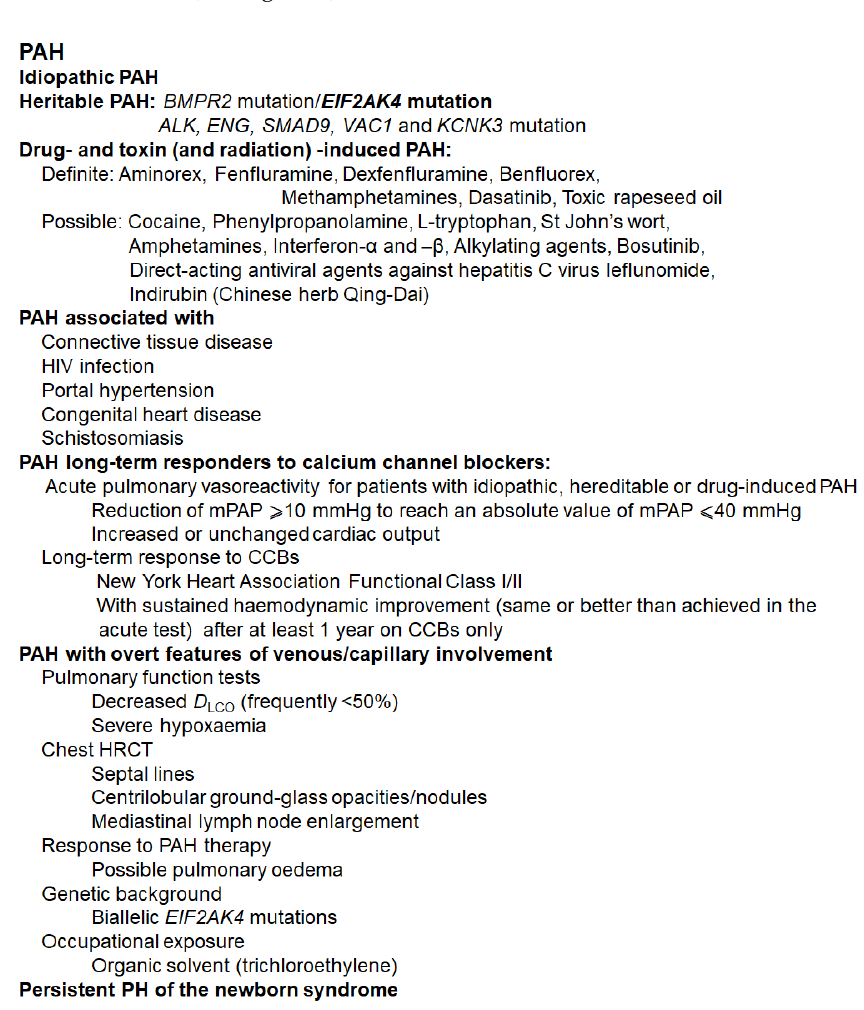
Figure 1. Current classification of PAH. Abbreviations: CCB, calcium channel blocker; mPAP, mean pulmonary arterial pressure; PVOD, pulmonary veno-occlusive disease; PCH, pulmonary capillary hemangiomatosis; DLCO, diffusing capacity of the lung for carbon monoxide; HRCT, high-resolution computed tomography; BMPR, bone morphogenic protein receptor type II.; ALK1, activin receptor-like kinase 1; ENG, endoglin; CAV1, caveolin-1; KCNK3, potassium channel, two-pore domain subfamily K member 3; and EIF2AK4, eukaryotic translation initiation factor 2α kinase 4 [2,4–6,8,10].